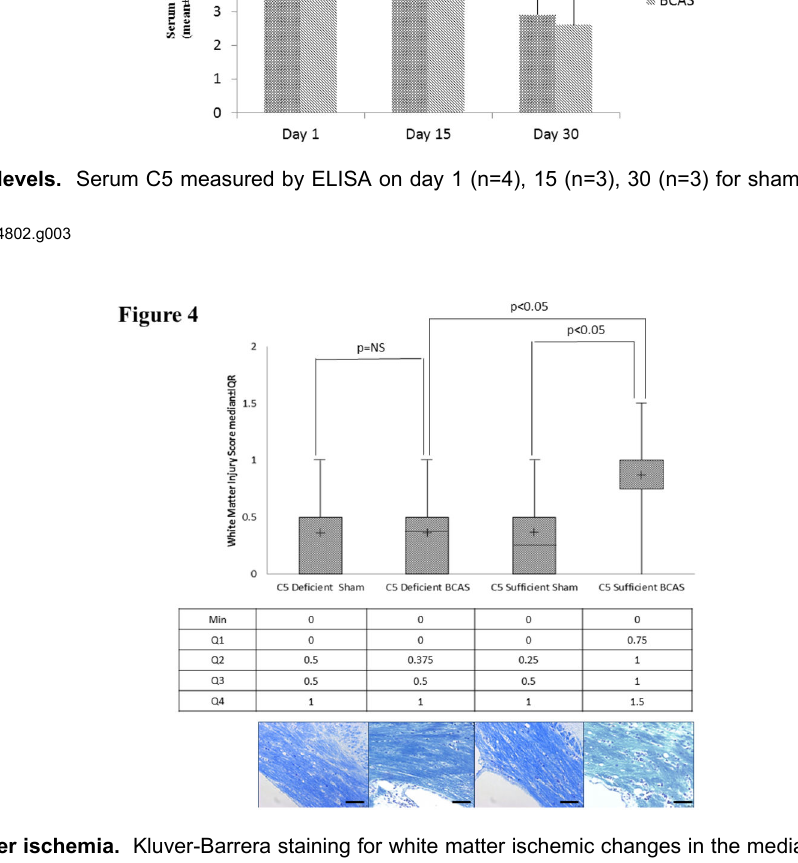
mice (0.375, IQR:0-0.5) demonstrated significantly less white matter injury than C5S BCAS mice (1.0, IQR:0.75-1.0, p<0.05). No differences in white matter injury existed between C5D sham (0.5, IQR:0-0.5) and C5D BCAS mice (0.375, IQR:0-0.5, p=ns). See figure 4.